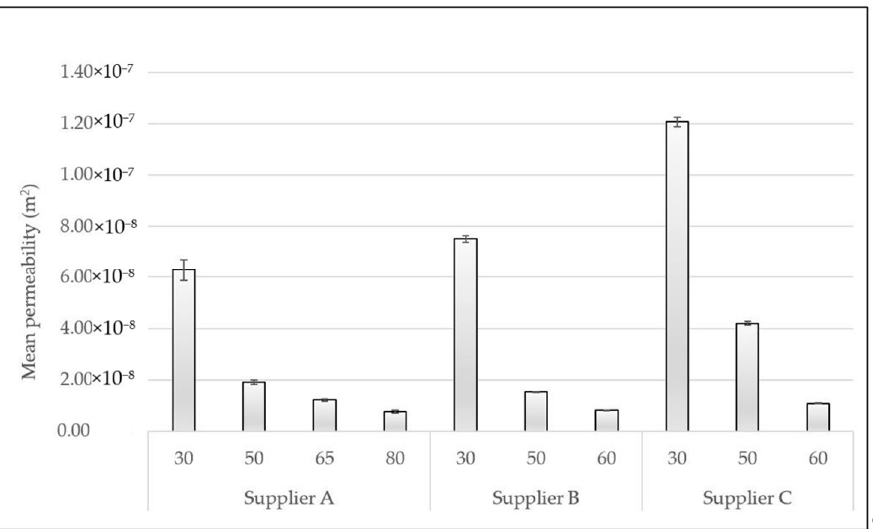
Figure 8. Mean permeability of CFFs of various Grades/PPI numbers from suppliers A, B, and